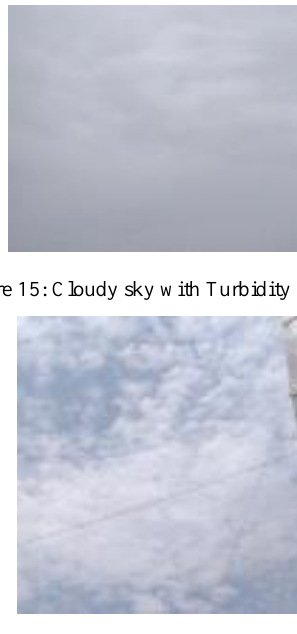
Figure 14: Turbidity vs Air Quality Index v. Variability of turbidity with weather condition was observed by taking the observations under different climatic conditions. During the months of April and May with clear sky conditions, Turbidity was observed in the range of 1 to 2.5. However in the month of June, at onset of Monsoon with cloudy weather, Turbidity value of 5.27 was obtained. Shows the two sky conditions.